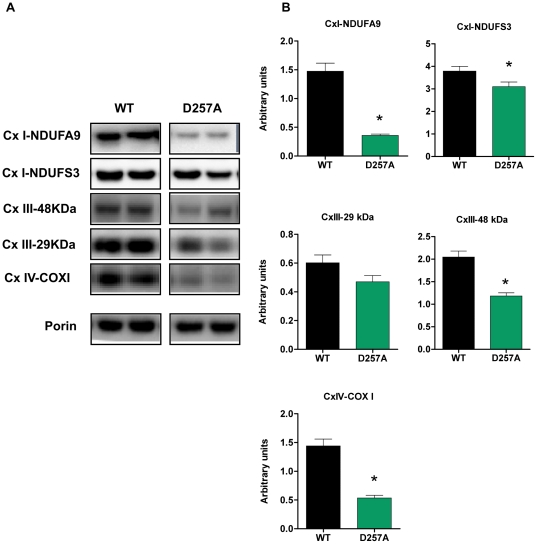
D257A mice show decreased protein expression of both nuclear-encoded and mitochondrial-encoded ETC subunits.(A) The content of selected nuclear-encoded (NDUFA9 and NDUFS3 subunits of Cx I, 29 kDa and 48 kDa subunits of Cx III), and mitochondrial-encoded subunits (COX I subunit of Cx IV) in skeletal muscle extracts of 11-mo old WT and D257A mice (n = 11 per group) were evaluated by Western Blotting. Representative blots are depicted. (B) Statistical analysis of ETC subunits protein expression. Arbitrary units represent densitometry values normalized to porin. Mean values ±SEM are shown. *p<0.05. Cx: complex.